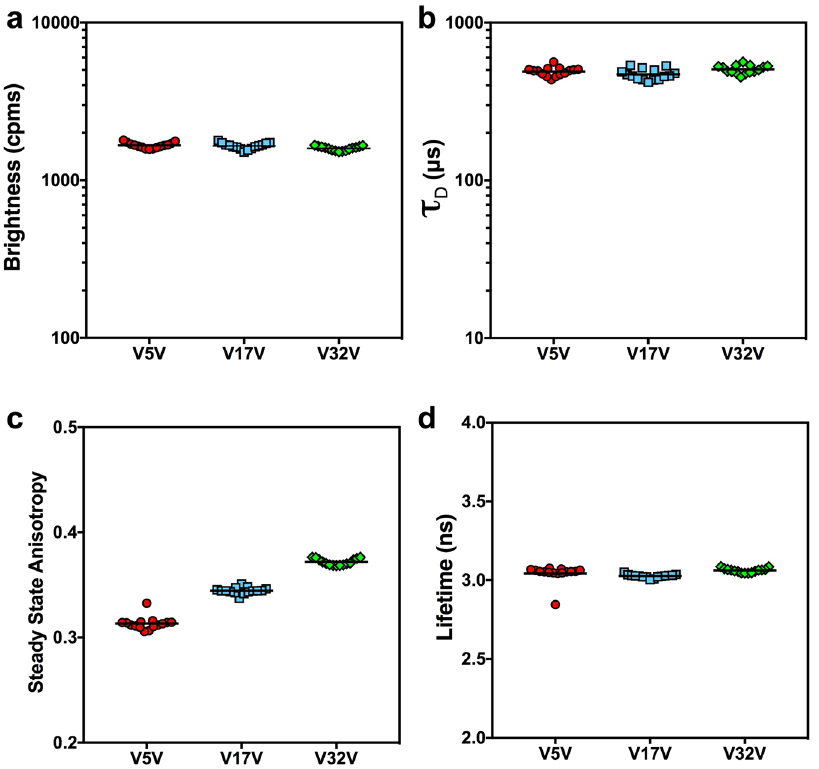
Figure 4. Auto-FPFA can detect subtle structural changes. Auto-FPFA was used to characterize V5V (red circles), V17V (blue squares), and V32V (green triangles). Each Venus dimers was composed of two Venus fluorophores separated by 5, 17, or 32 amino-acid linkers respectively. Auto-FPFA measurements of molecular brightness ( a ), diffusion time ( τ D , b ), steady state anisotropy ( c ), and lifetime ( d ) of the three types of Venus dimers. For each Venus dimer sample three cell homogenates were prepared and five replicates were measured for each homogenate. Red bars indicate the mean, N = 15 (5 replicates of 3 homogenates for each dimer construct). Note the outlier that is easily detected in the V5V sample in panels c and d. We checked if the location on the micro-titer dish for this outlier was the same as the outlier previously observed in Fig. 3. It was not, indicating that it is unlikely that the outliers resulted from a systematic error in X/Y-axis